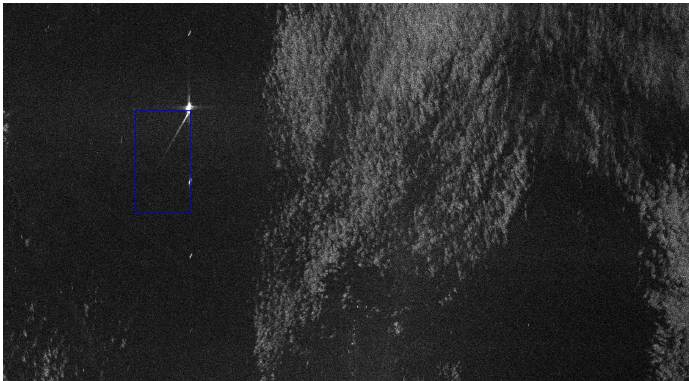
Figure 10. Detections over Scenario C (Azimuth-Ground Range